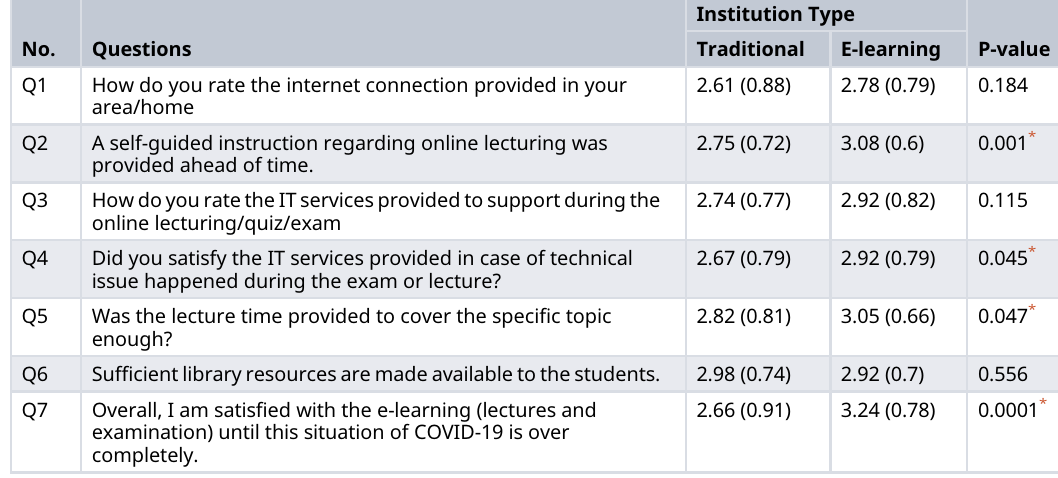
Table 4. Comparsions of average scores with standard deviation between the type of